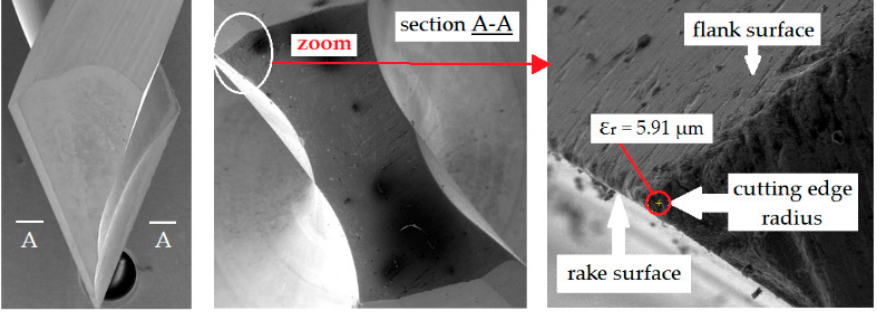
Figure 11. Measurement of radius of the drill’s cutting edge. Table 3. Machining conditions.